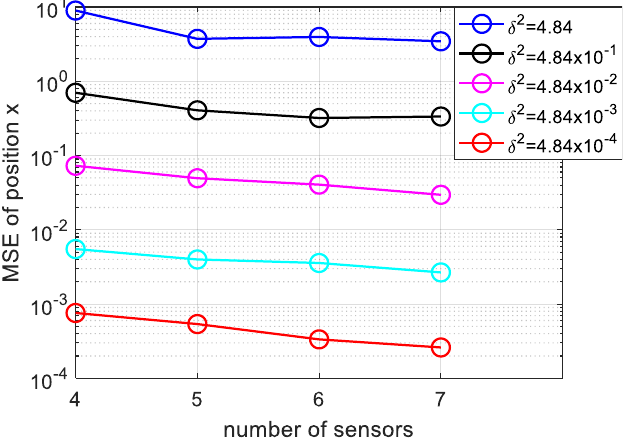
Figure 8. Variation of MSE of position x with more sensors and varying measurement noise, the sensors number is m = 4, 5, 6, 7.